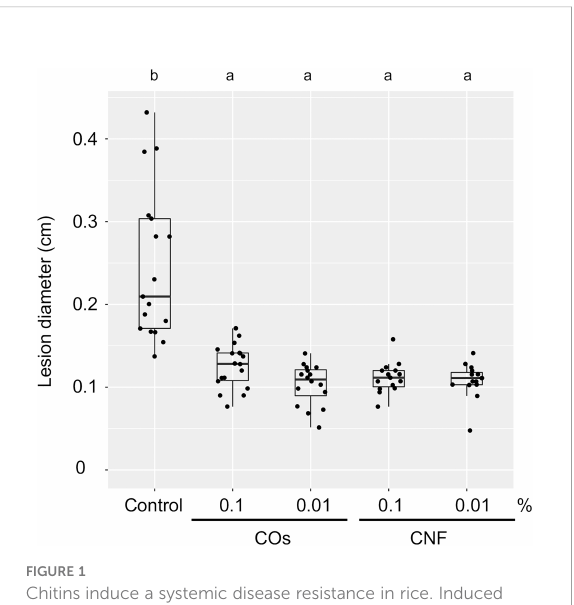
FIGURE 1 Chitins induce a systemic disease resistance in rice. Induced systemic disease resistance against Bipolaris oryzae by chitins, as measured by lesion diameter (in centimetres) of leaves two days after inoculation. Three-week-old rice seedlings grown on soil mixed with distilled water (DW; Control) and 0.1% or 0.01% (w/v) chitin oligomers (COs) and chitin nano fi ber (CNF) were inoculated with B. oryzae . Different letters indicate signi fi cant differences by Tukey ’ s test ( p < 0.05, n > 14). Representative results from three independent experiments are